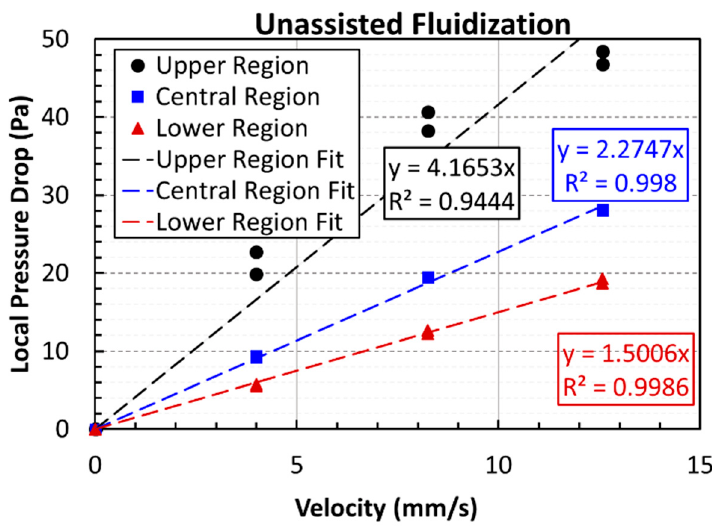
Figure 13. Local pressure drop variations with velocity and corresponding linear-fits for the defluidization cycle of unassisted fluidized bed.